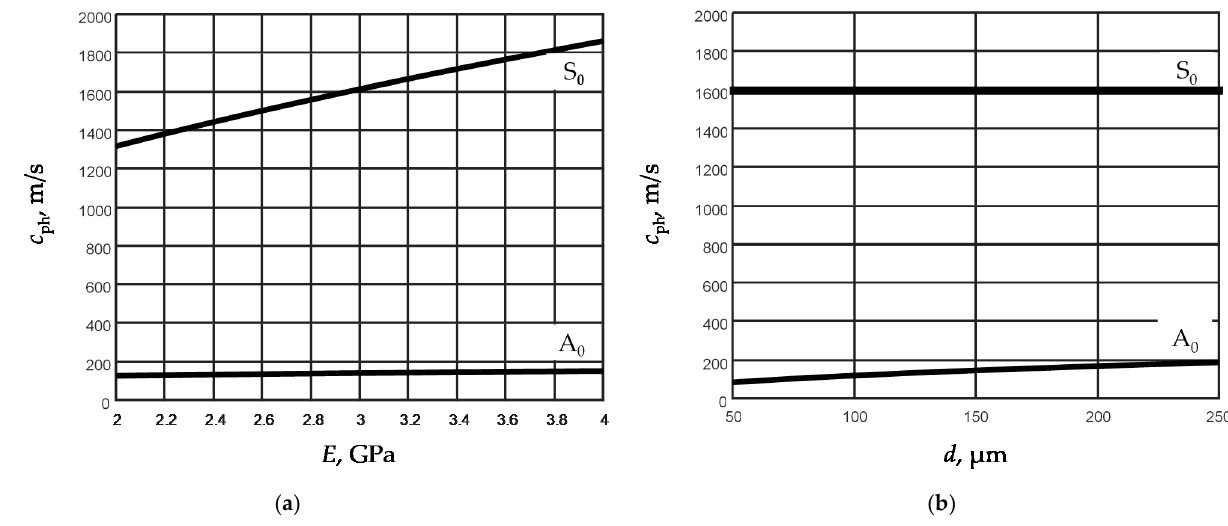
Figure 2. Dependences of the phase velocities of Lamb wave modes A 0 and S 0 in the PVC film on the Young’s modulus E ( a ) and the film thickness d ( b ) when the film thickness d = 150 µm ( a ) and the Young’s modulus E = 2.937 GPa ( b ).